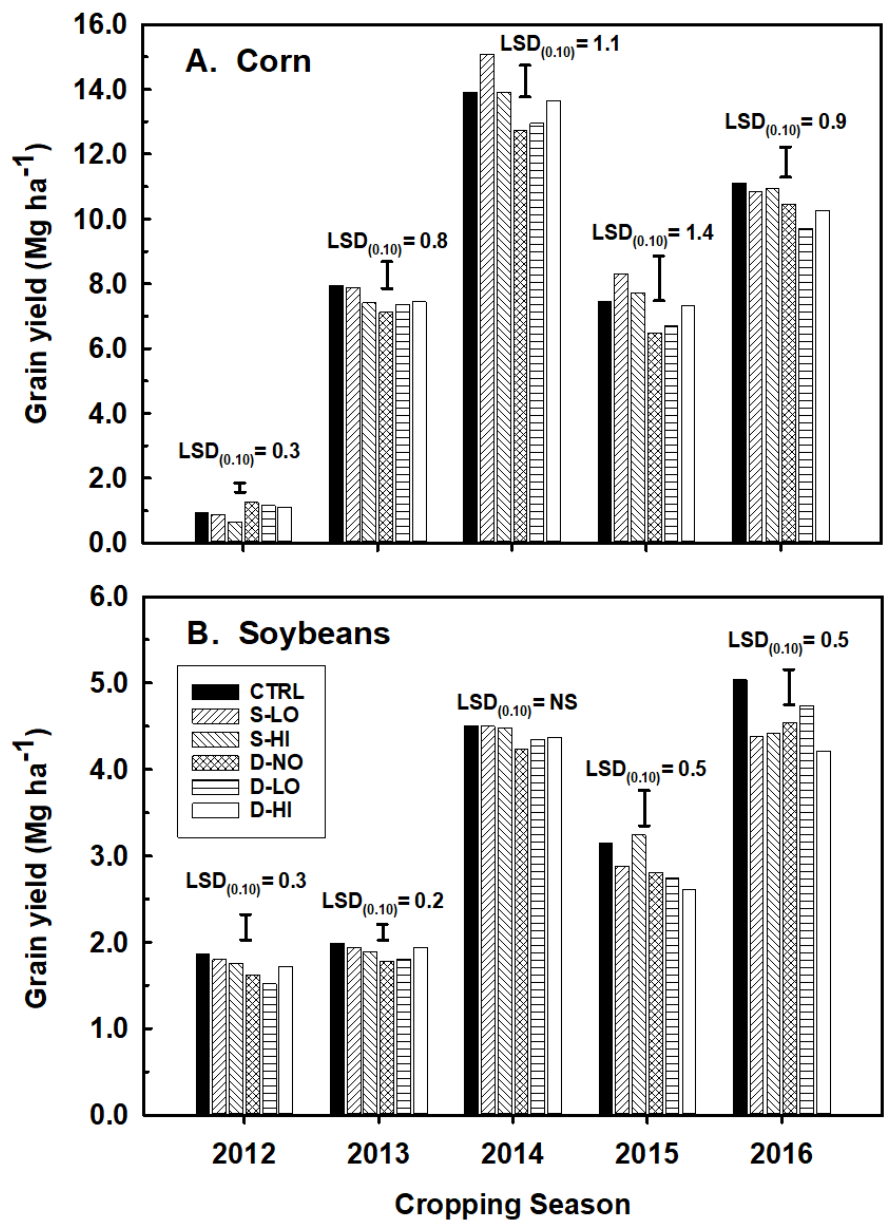
Figure 3. ( A , B ) Trial #1 grain yields (Mg ha −1 ) for ( A ) corn and ( B ) soybean, due to lime treatments from the 2012 to 2016 cropping seasons. LSD (0.10) is least significant differences at p ≤ 0.10. (Abbreviations: CTRL, control; S-LO, surface 3.4 Mg ha −1 ; S-HI, surface 6.7 Mg ha −1 ; D-NO, deep tillage no lime; D-LO, deep placement 3.4 Mg ha −1 ; D-HI, deep placement 6.7 Mg ha −1 ; NS, not significant).